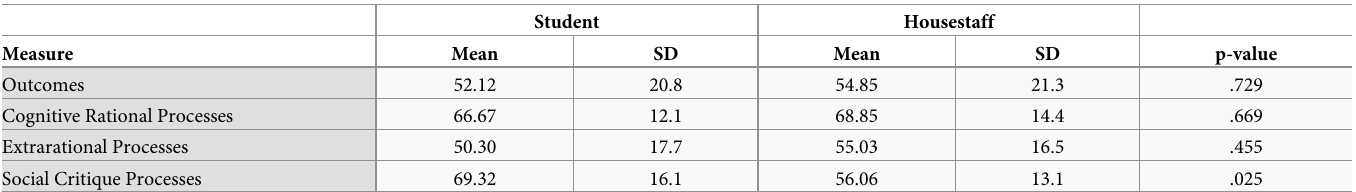
Table 3. Tests of group differences in TL domain